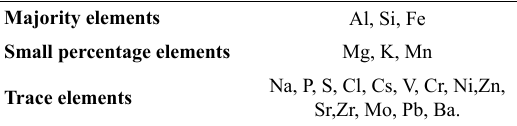
Table 2. Atomic Absorption Spectrometry (Qualitative) of Sulfatreat waste. Majority elements Al, Si, Fe Small percentage elements